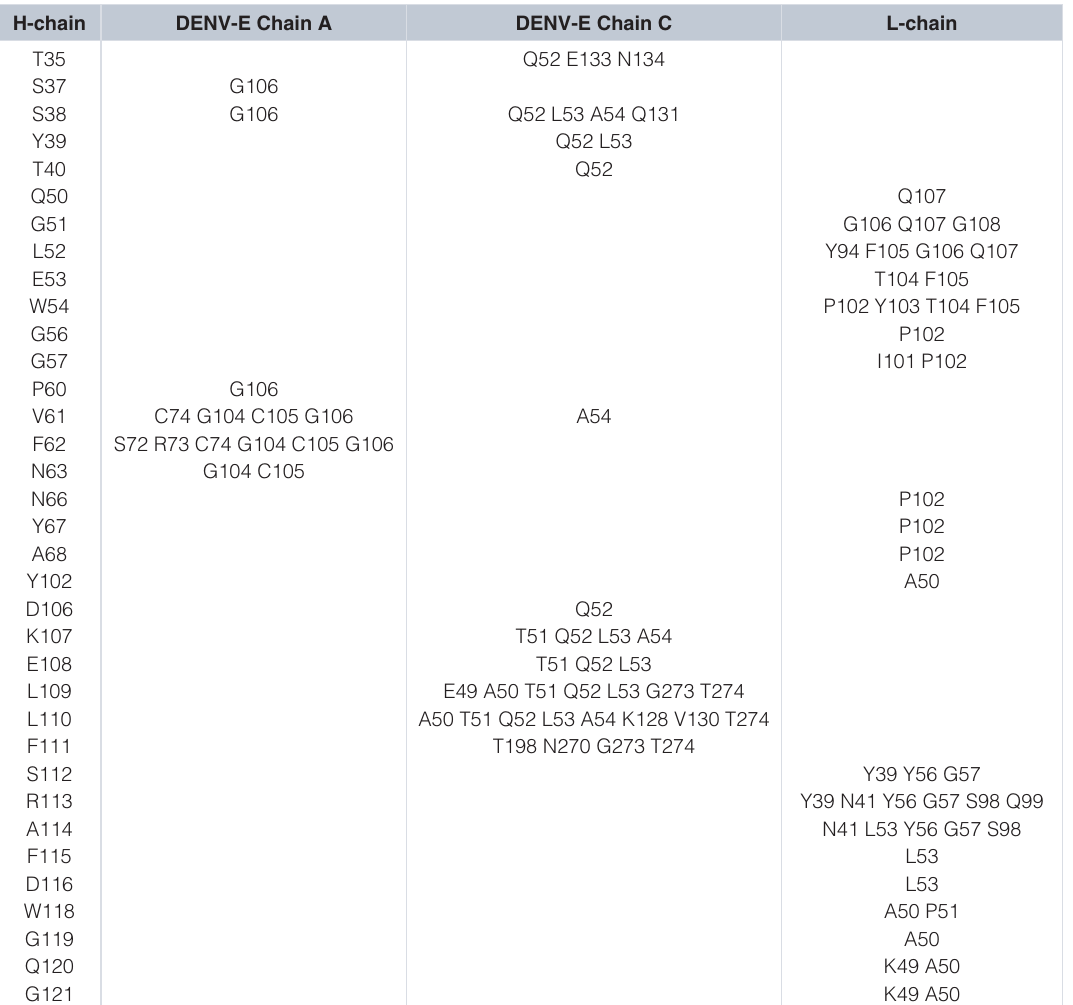
Supplementary Table 1. Interacting residues of the heavy chain (PDB ID:3J6UH) of the potent DENV antibody 5J7 with other subunits. Interacting residues are identified as those with C α atoms within 8 Å of each other. The